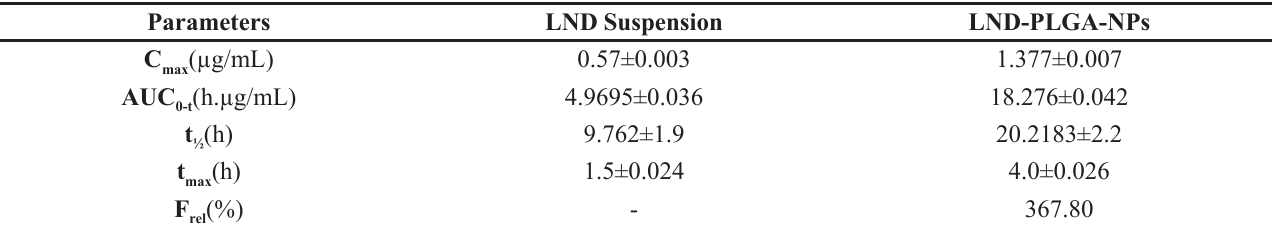
TABLE I - Pharmacokinetic parameters of lenalidomide after oral administration of LND loaded PLGA-NPs and suspension at the dose of 30